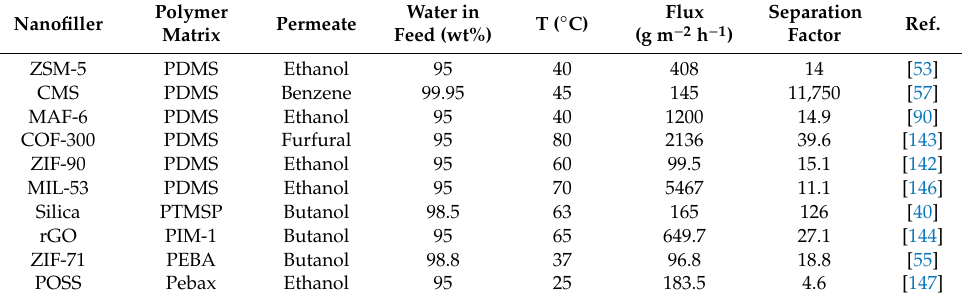
Table 4. Typical nanofillers used in PV separations of organics from organic–aqueous